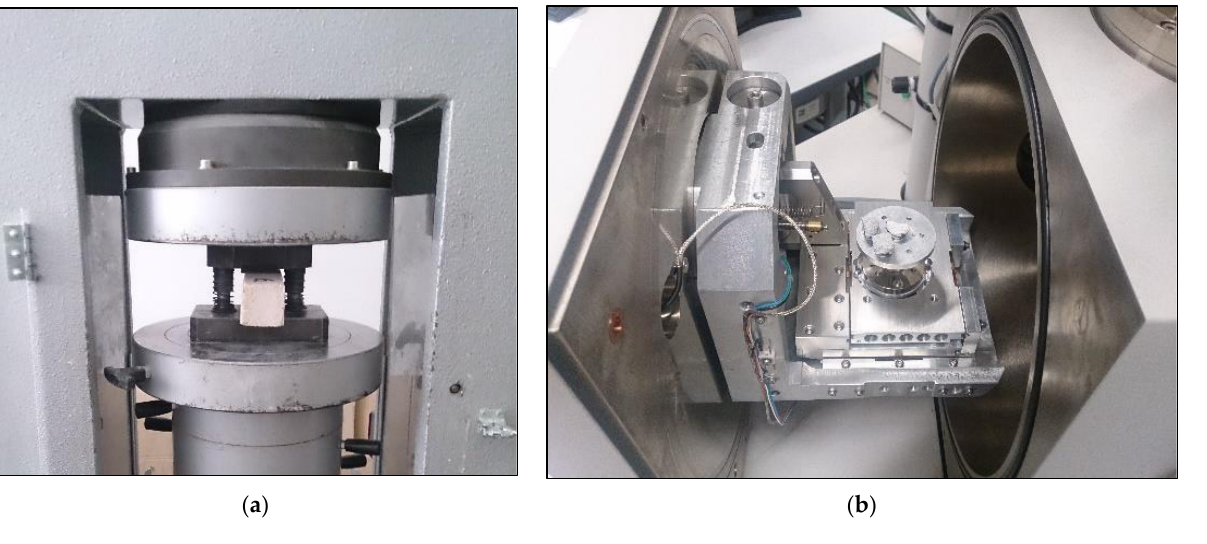
Figure 4. Equipment used during the tests: ( a ) compressive strength testing machine; ( b ) scanning